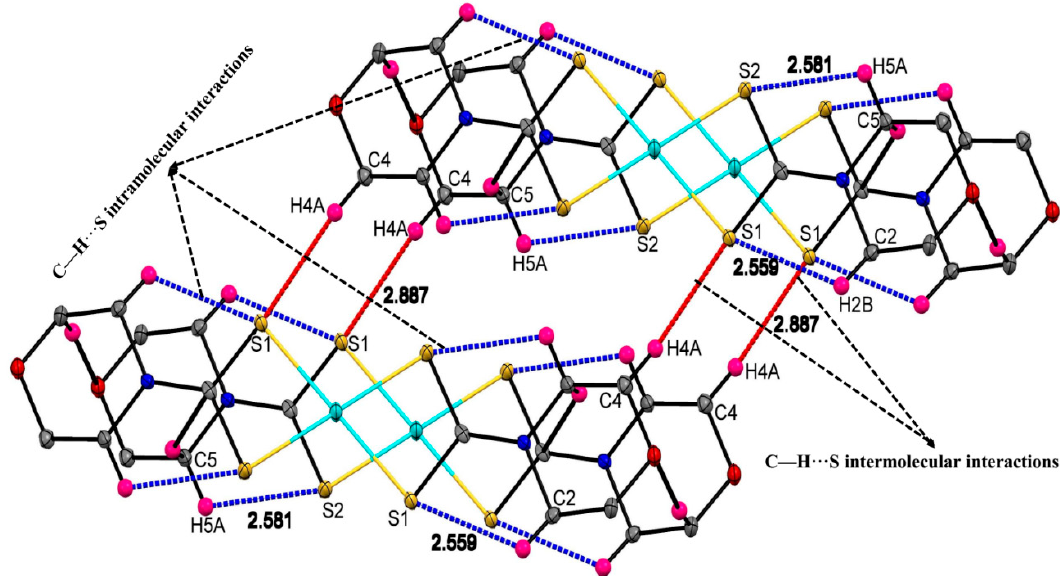
Figure 1. Molecular structure of [Cu(MphDTC) 2 ] showing an atomic labeling displacement ellipsoid at a 50% probability.